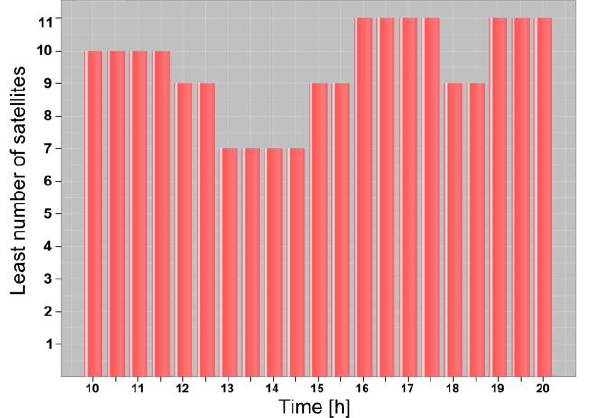
Figure 6: Minimum number of GPS satellites as a function